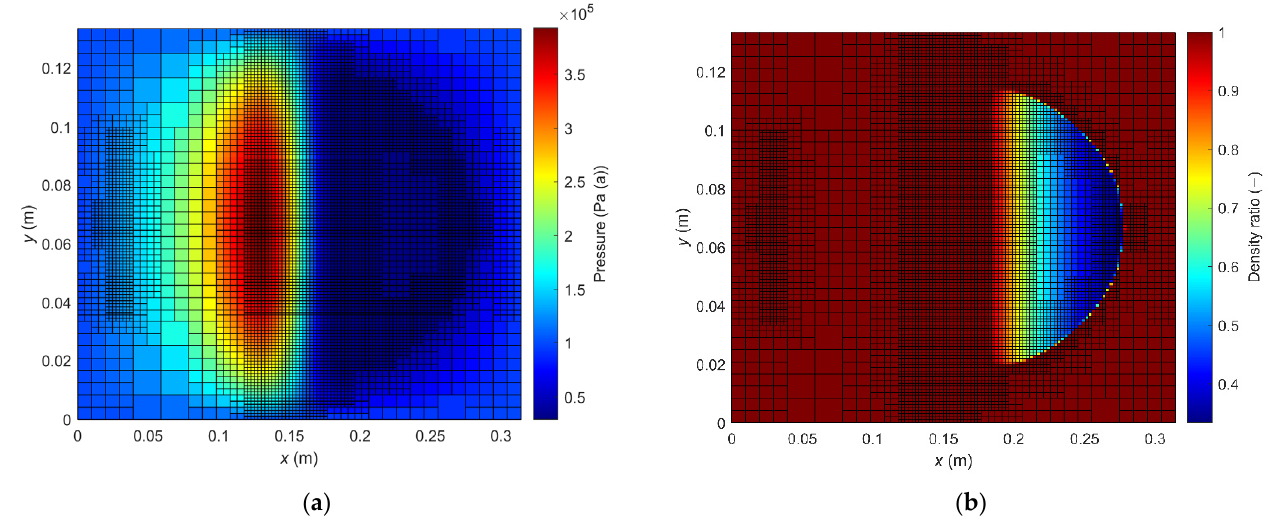
Figure 9. Final refined mesh for journal bearing: ( a ) pressure distribution; ( b ) density ratio distribution.